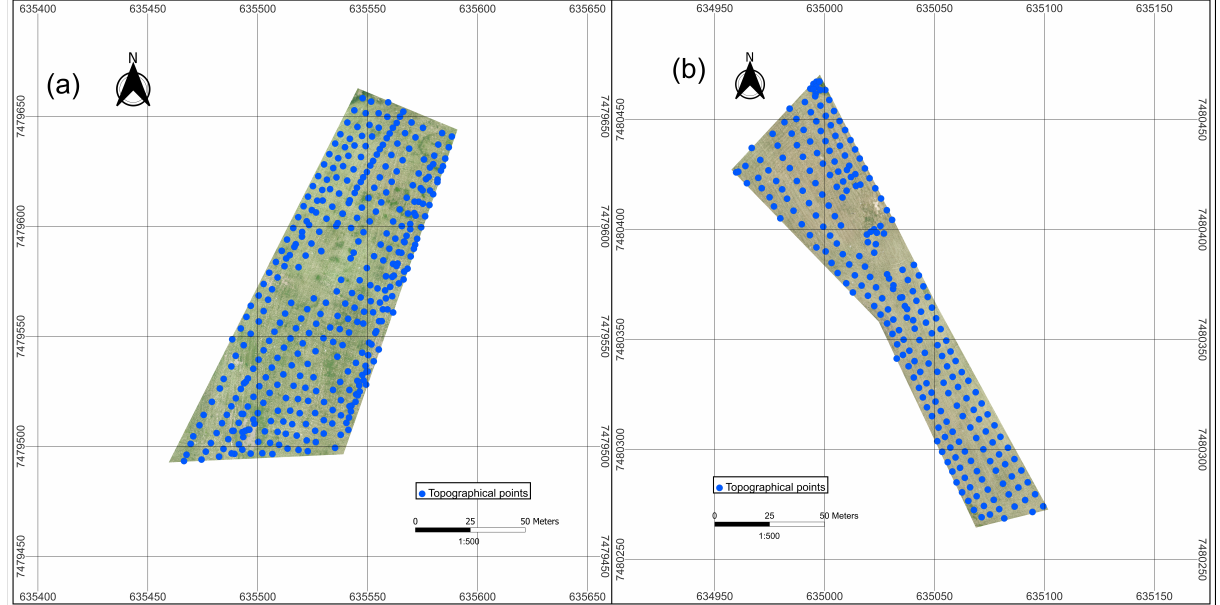
Figure 5. Surveyed points from the areas of Seropédica municipality: ( a ) location of points registered in area 3 by conventional topographic survey and ( b ) location of points registered in area 4 by the conventional topographic survey.